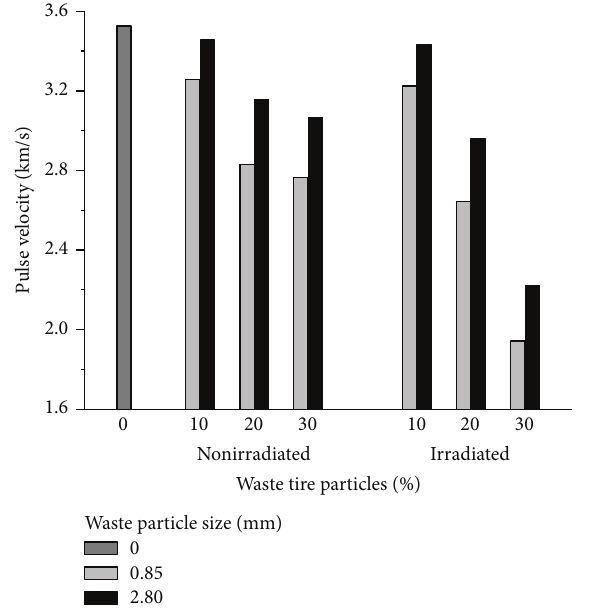
Figure 6: Pulse velocity of concrete with waste tire particles.